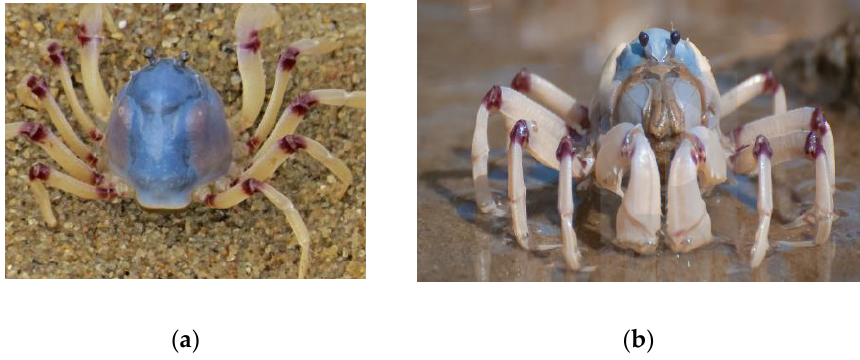
Figure 1. Blue Soldier crab: ( a ) Soldier crab during the resting position and ( b ) soldier crab while